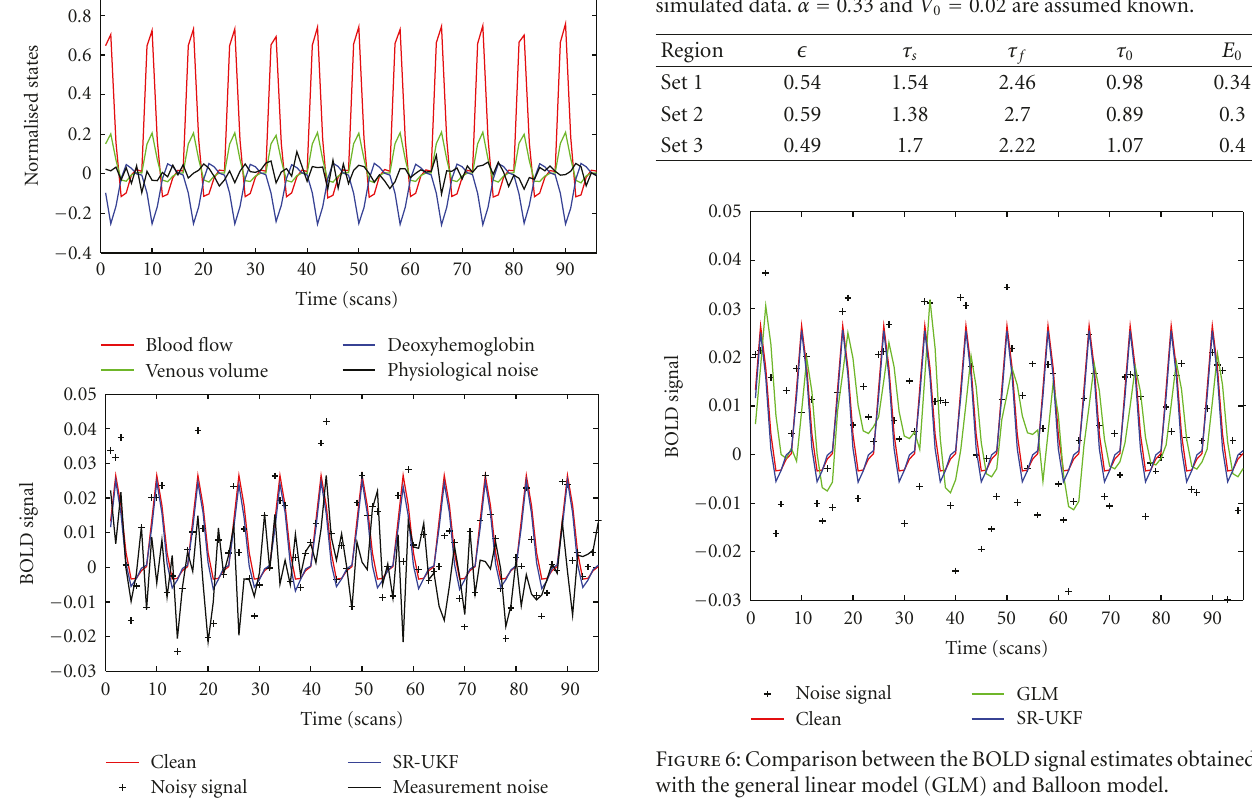
Figure 5: Reconstructed blood oxygen level-dependent (BOLD) signal from estimated states.